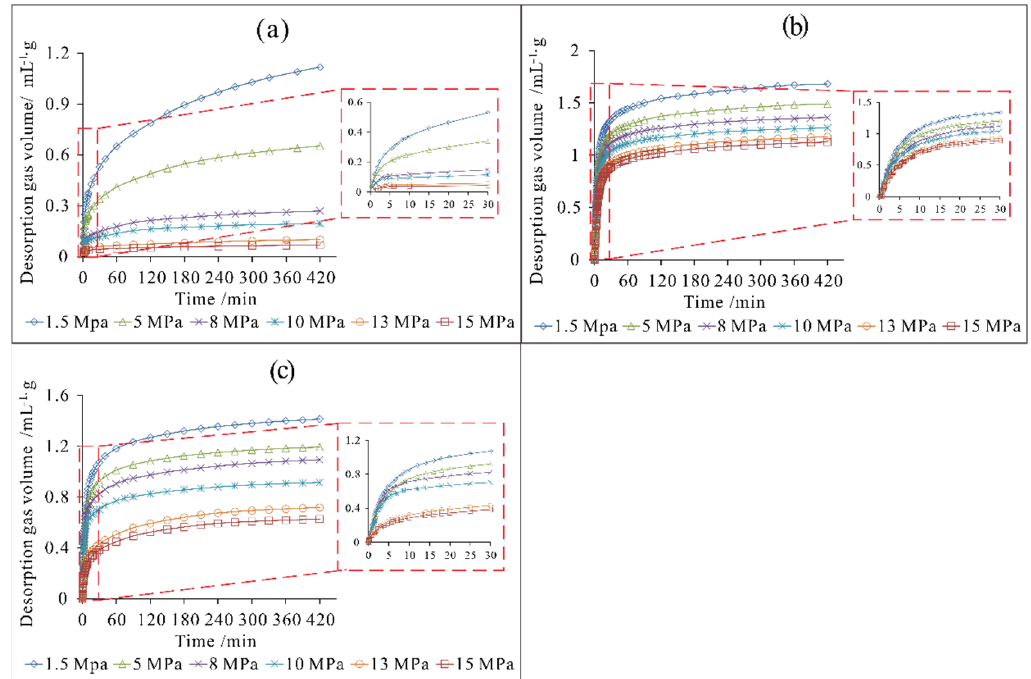
Figure 8. The change of desorption gas volume and desorption rate with time: ( a ) is the PUC sample; ( b ) is the BDC sample; ( c ) is the DDC sample.